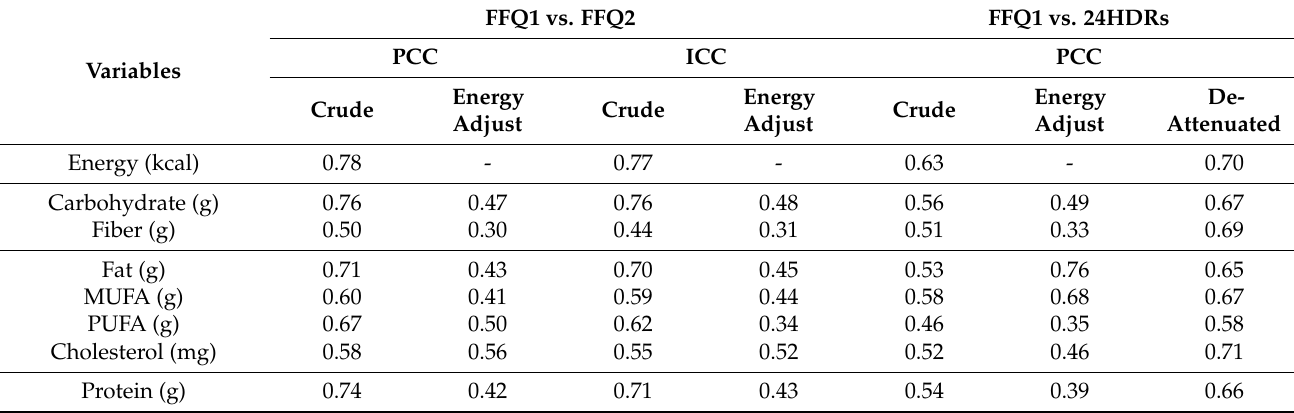
FFQ: food frequency questionnaire, 24HDR: 24 h dietary recall, MUFA: monounsaturated fatty acids, PUFA: polyunsaturated fatty acids. 1 Differences were tested by using paired t -test. 2 Nutrient intakes were analyzed using the Indonesian Food Composition Data. 3 Nutrient intakes were analyzed using the United States Department of Agriculture (USDA). Table 4. Correlation coefficients for nutrient and food group intakes between FFQ1 and FFQ2 and between FFQ1 and the mean of